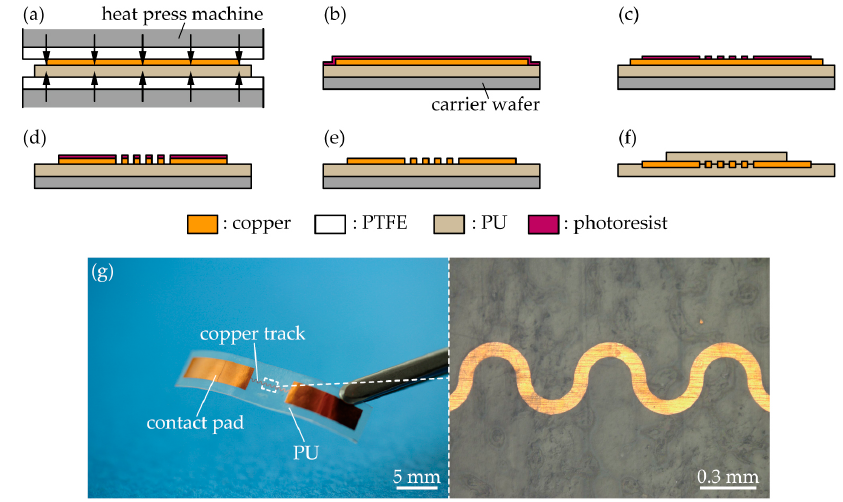
Figure 3. Fabrication of a wave-shaped copper track embedded in PU. ( a ) Lamination of a copper foil on a PU sheet; ( b ) Spin-coating of a photoresist on the copper foil; ( c ) Development and patterning of the photoresist; ( d ) Wet-etching of the copper foil; ( e ) Removal of the photoresist; ( f ) Lamination of a PU tape on the structured copper; and, ( g ) Optical images of a wave-shaped copper track in